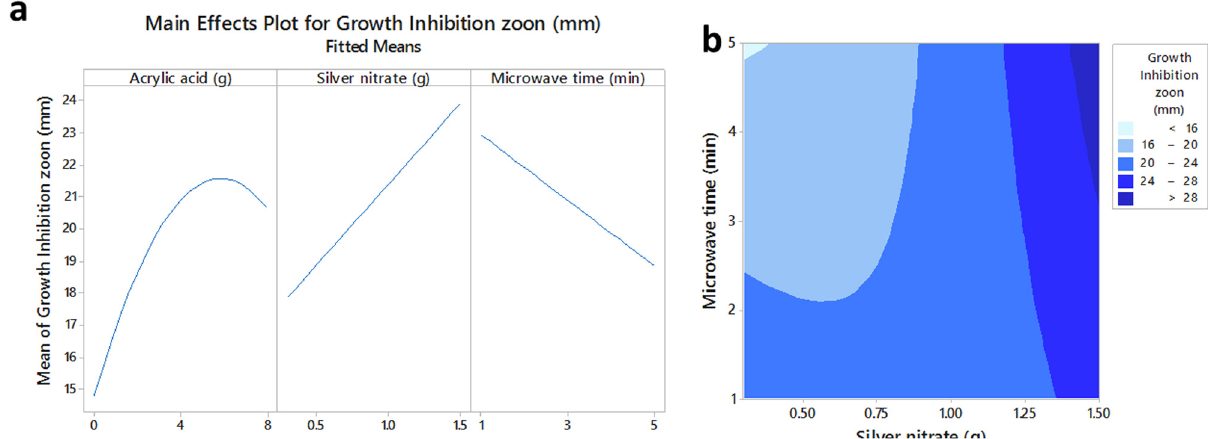
Figure 4: The main e ff ects plot ( a ) and the contour plot ( b ) of acrylate acid, silver nitrate and microwave time on growth inhibition of sodium alginate/acrylic acid composite hydrogels conjugated to silver